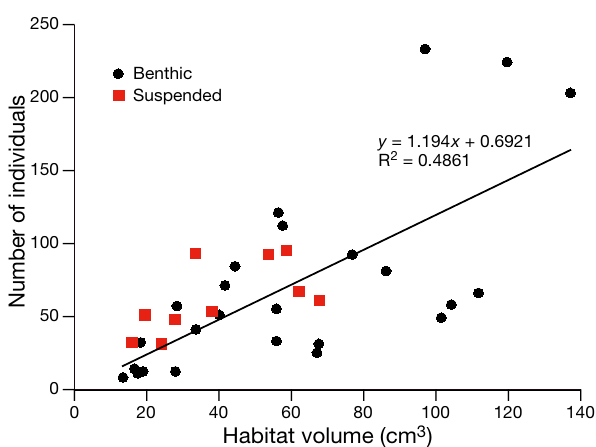
Fig. 4. The relationship between holdfast habitat volume and number of individuals per holdfast for benthic and